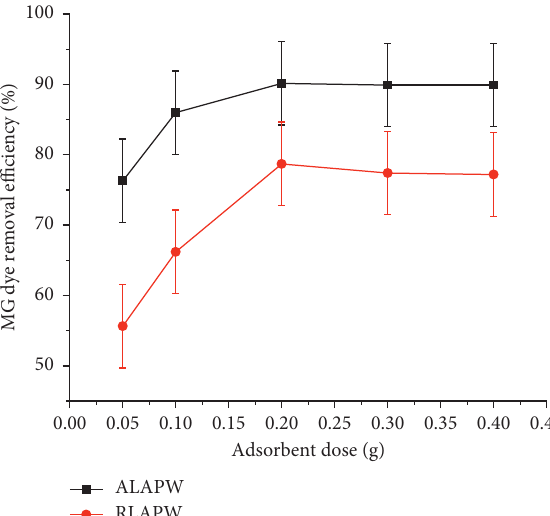
Figure 4: pH effect on the adsorption of MG dye by ALAPW and RLAPW at adsorbent dose 0.2g. MG dye concentration 10mg/L, contact time 60min, agitation speed 200rpm, and room temper- ature (298 K).